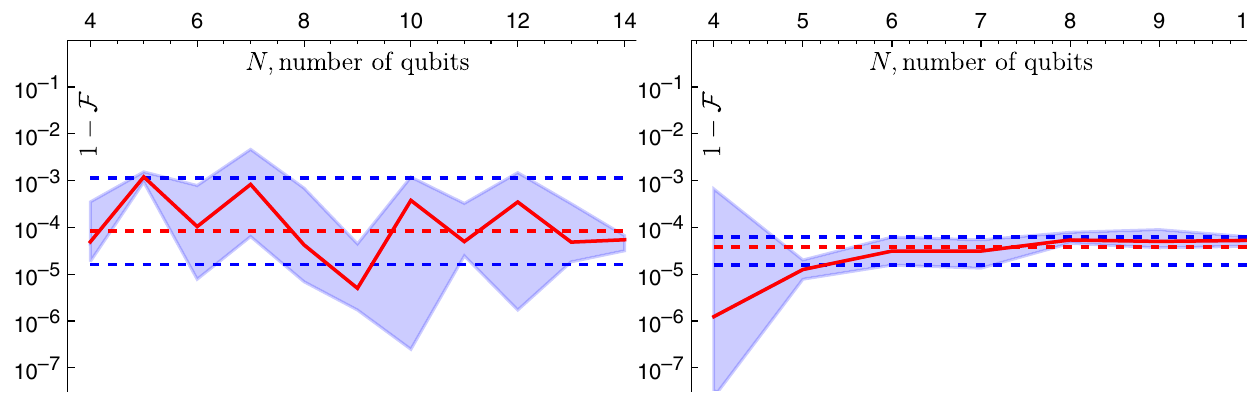
FIG. 15. Scaling results showing the infidelity with respect to the ground state of the state achieved after 20 steps of CoVaR from an initial state of F overlap with the ground state. The red curve and blue shaded region show the median and quartiles of ten runs of init CoVaR for each N , and the dotted lines show the median and quartiles of the data as a whole. Left: simulations for our recompilation 50% and a constant Ansatz depth of two layers. Right: simulations for the problem from Sec. IVA using a constant initial fidelity F init ¼ spin-chain problem using an increasing Ansatz depth that can estimate the ground state to at least an infidelity of 10 − 5 . An initial overlap 80% is used to suppress convergence to excited states, and only the runs that do converge to the ground state (and not to an of F init ¼ excited state) are included in the present statistics. Compared to our recompilation simulations (left) using a constant Ansatz depth, here the performance may appear to be decreasing slightly as we increase the number of qubits — which would be explained by the increasing depth (polylogarithmically in Sec. III A) of the Ansatz circuit.